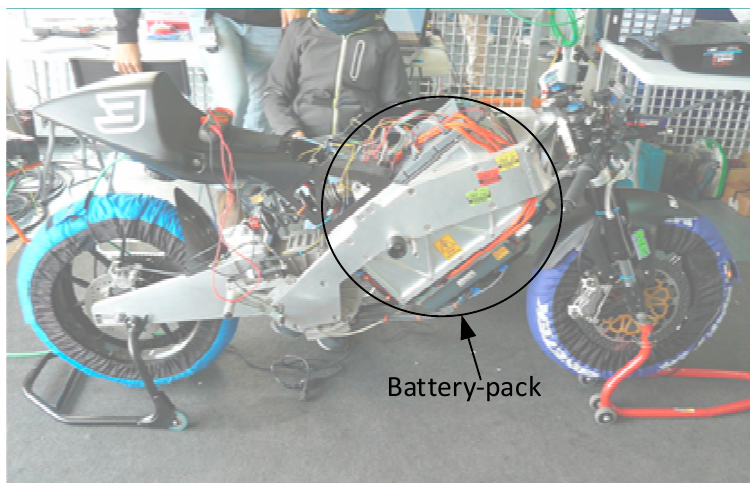
Figure 12. Battery-pack position in the motorbike.